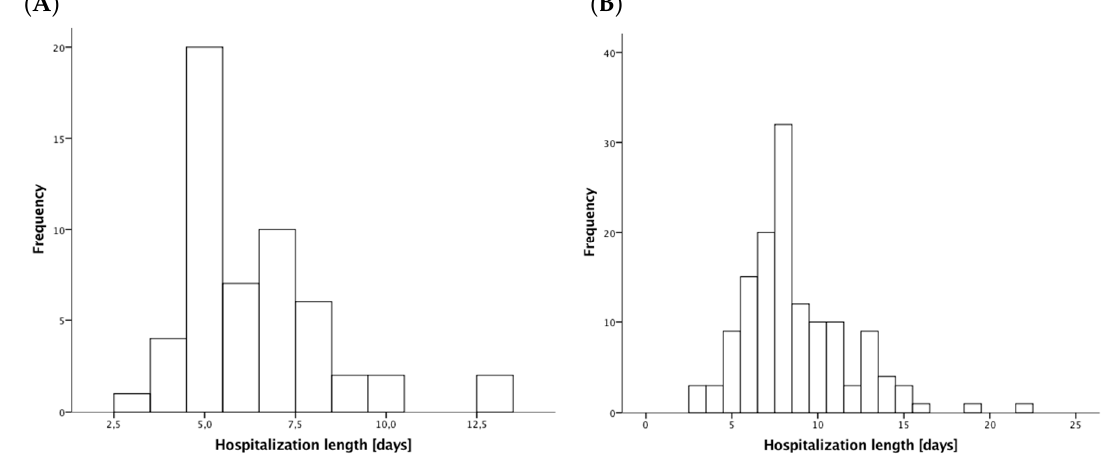
Figure 2. Histogram of length of hospital stays in low-risk patients ( A ) and higher-risk patients ( B ). 108 By definition, low-risk patients were younger, with higher LVEF, and did not have MVD and